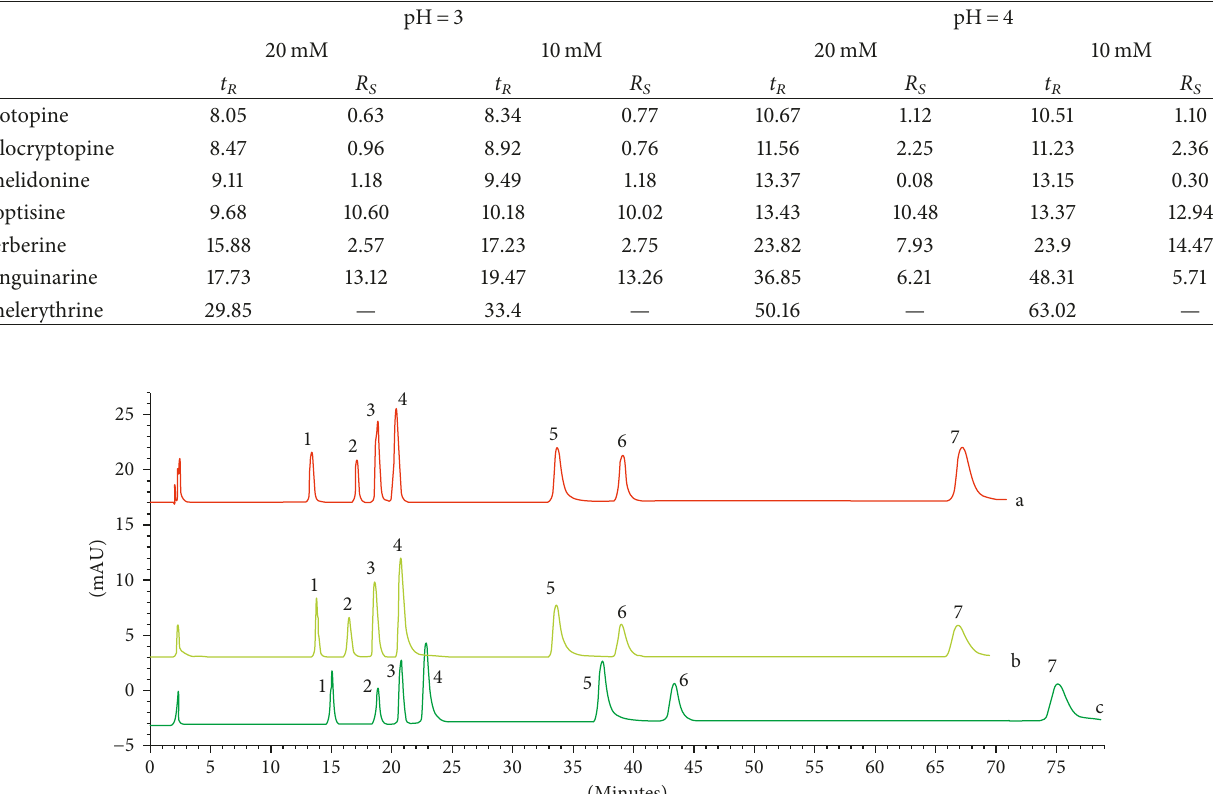
Table 2: The comparison of retention times and peak resolutions of investigated alkaloids in 35% of methanol in water at different pH and ammonium acetate concentrations.